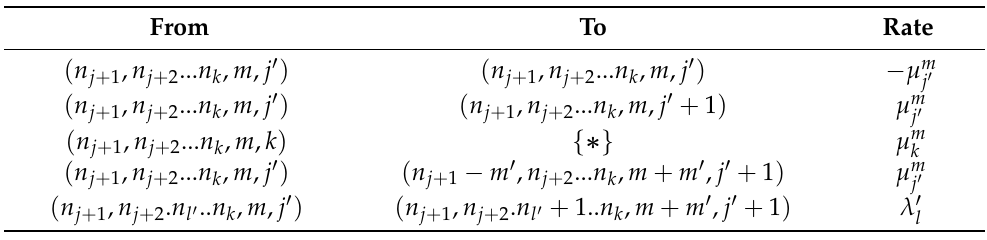
Table 7 indicating the transitions and respective rates is given below: Table 7. Transition